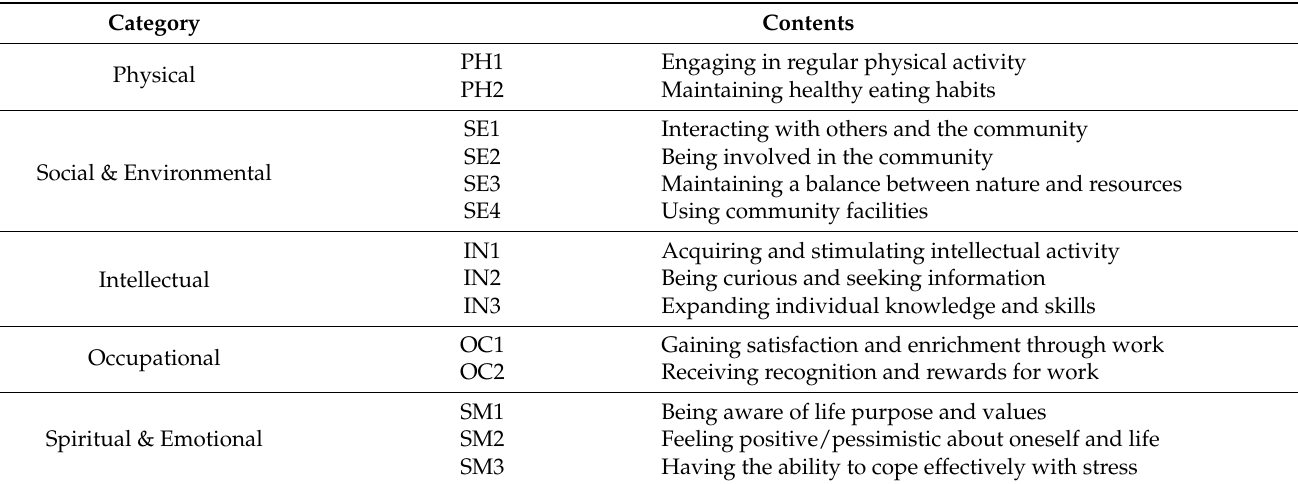
Table 2. Wellness measurement